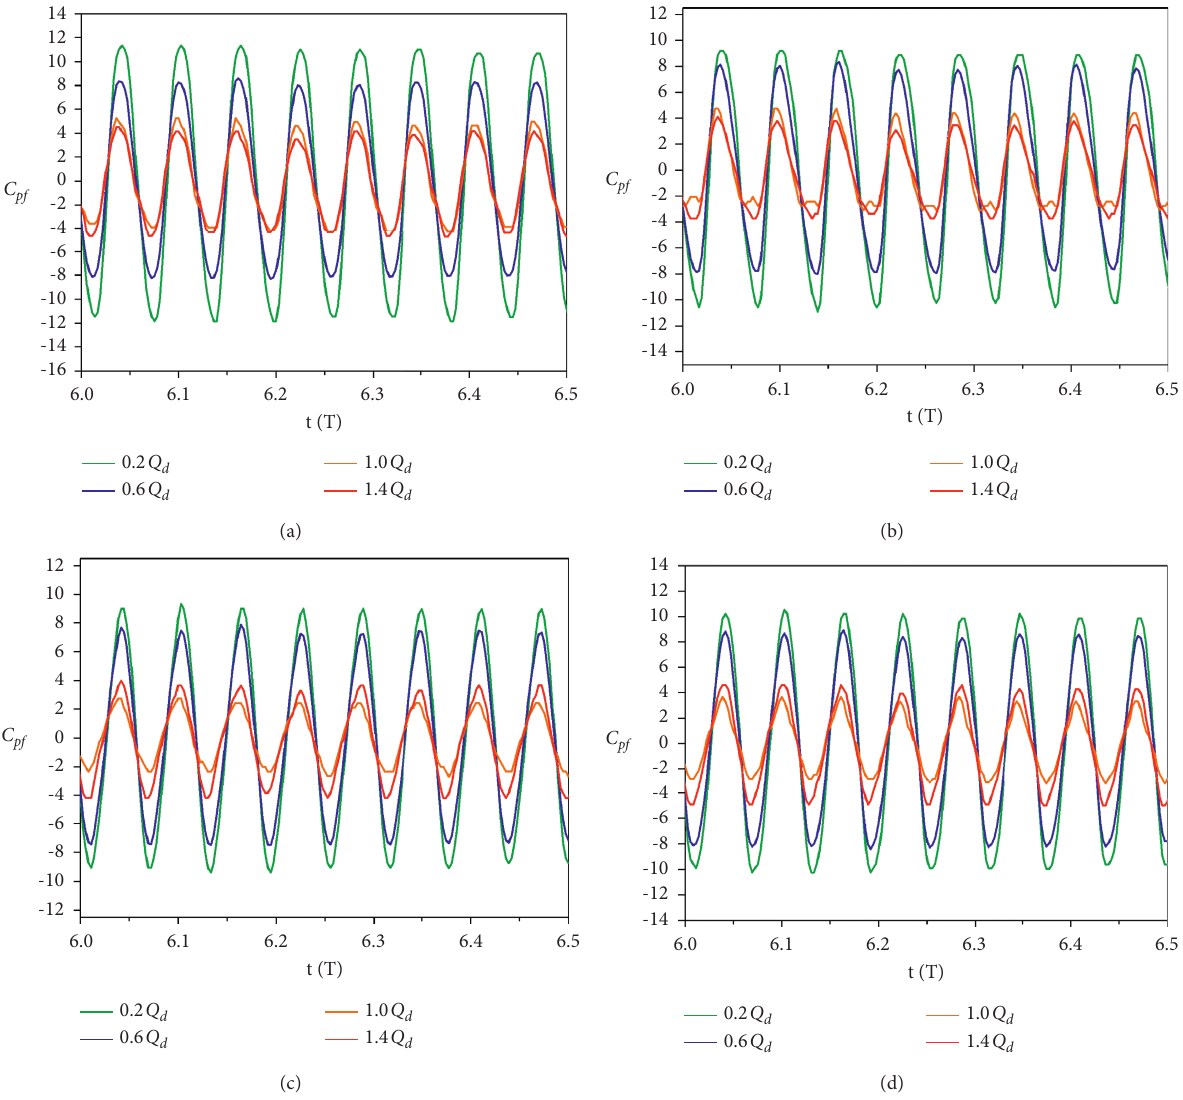
Figure 10: Time-domain pressure signals of the diffuser at the upstream and downstream of the tongue area with different flow rates for monitoring points: (a) 1, (b) 2, (c) 5, and (d) 6.